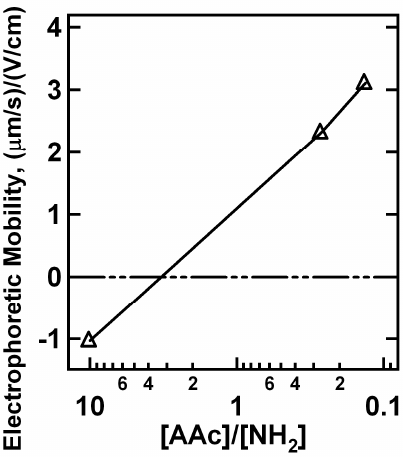
Figure 4. Electrophoretic mobility values as a function of PAH addition for 2% BIS and 10% AAc nanogels upon 5.0 μ L PAH aliquot additions. Note the pH of solutions adjusted at 6.5 with 10 mM NaCl.